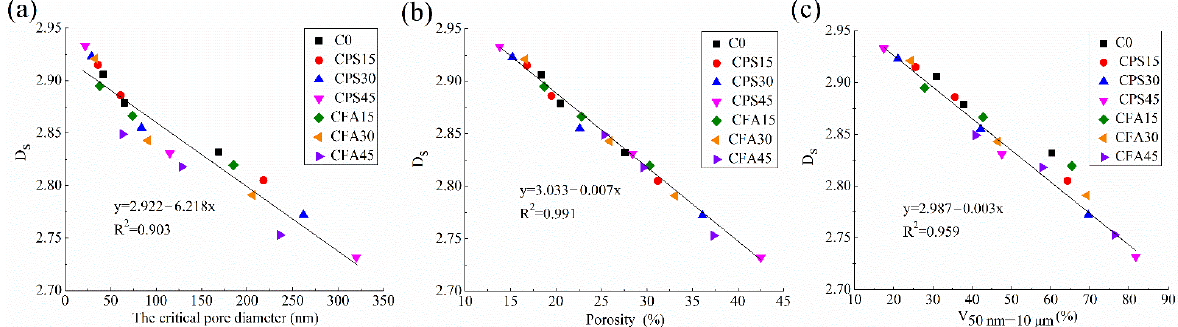
Figure 5. The correlation between D s and ( a ) the critical pore diameter, ( b ) porosity and ( c ) V 50 nm – 10 μm of concrete.